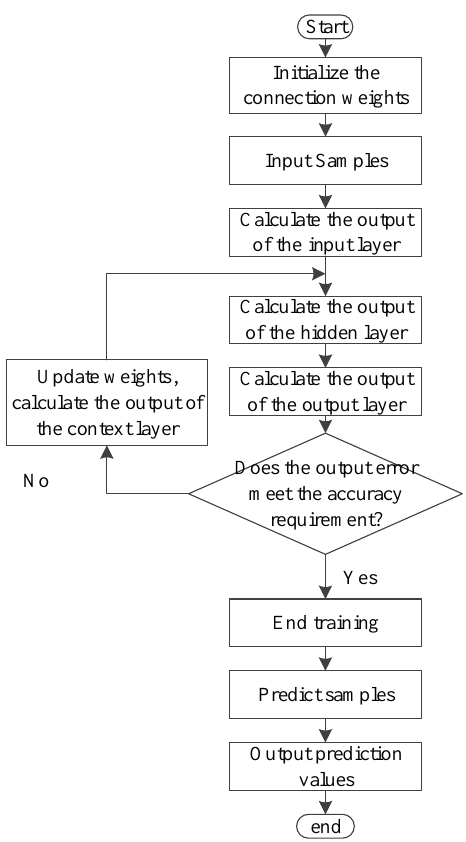
Figure 4. The flowchart of electrical load forecast by